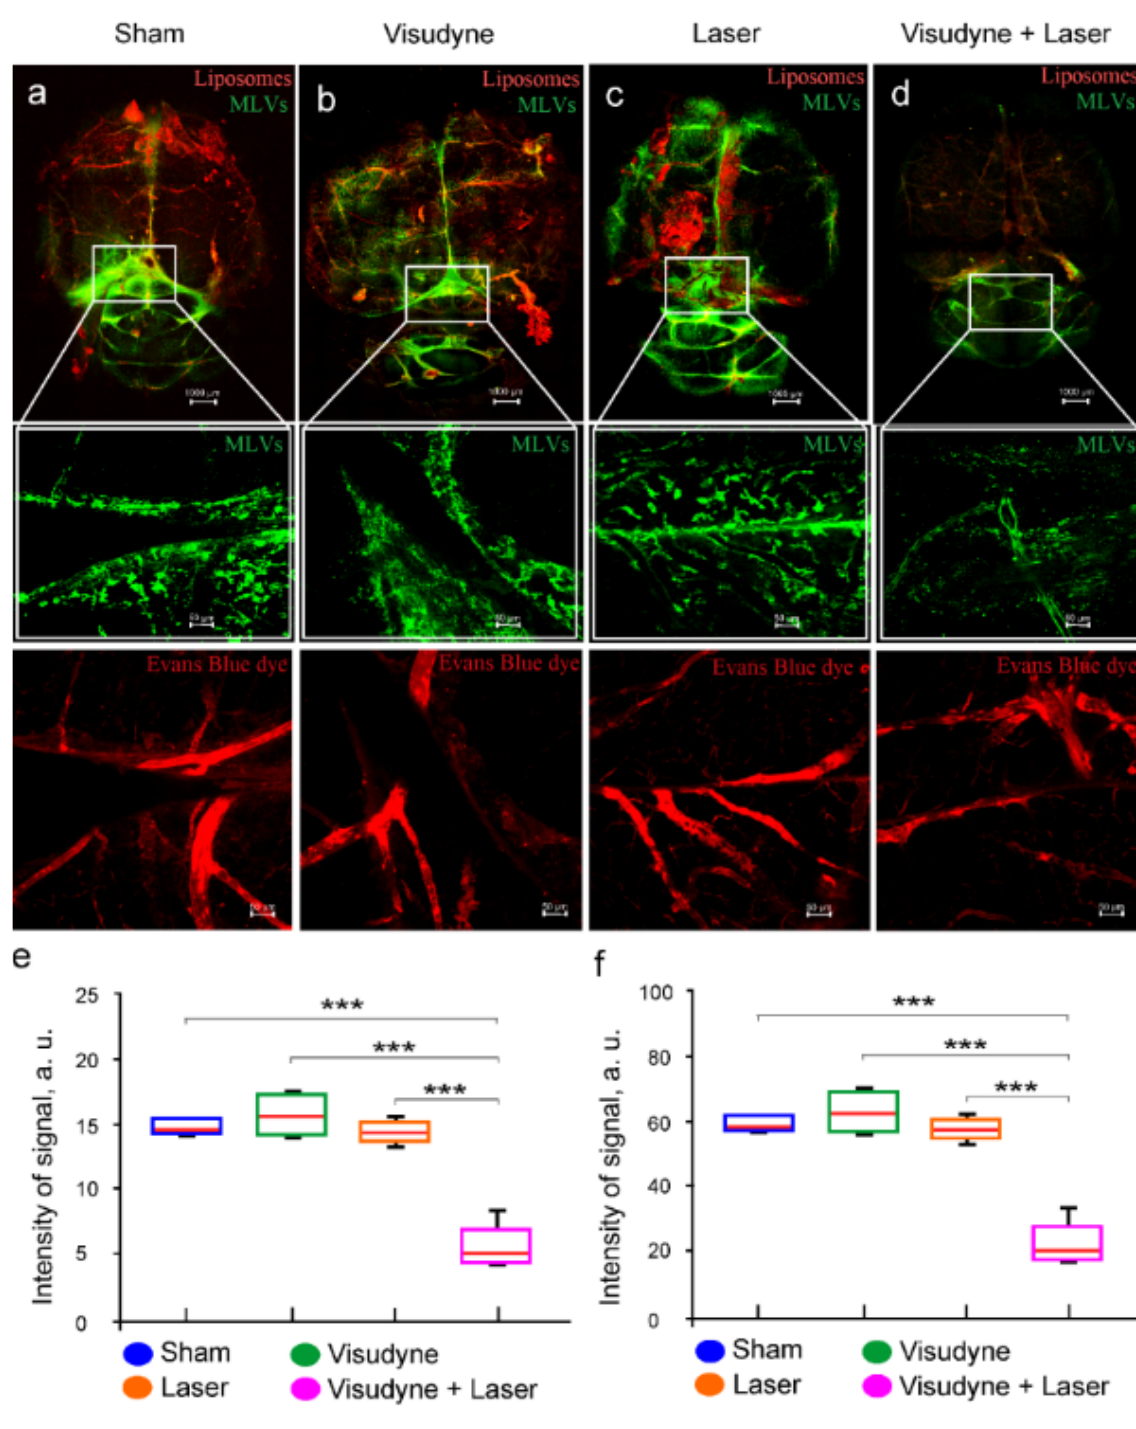
Figure 2. The effects of photo-ablation of the MLVs (green) on intranasal delivery of liposomes (ex.578/em.602) to the brain. ( a – c ) Representative confocal images of the MLVs labeled with Lyve-1 (green) in the sham group ( a ), in the visudyne group ( b ), in the laser group ( c ), and in the visudyne + laser group (photo-ablation of the MLVs) ( d ), n = 5 in each group. The cerebral vessels were filled with Evans Blue (ex.640/em.680); ( e , f ) quantification of percentage area of the LYVE-1- positive MLVs ( e ) and the intensity of fluorescent signal from liposomes ( f ) in the brain tissues in the tested groups, n = 5 in each group, *** p < 0.001 the Mann–Whitney–Wilcoxon test.